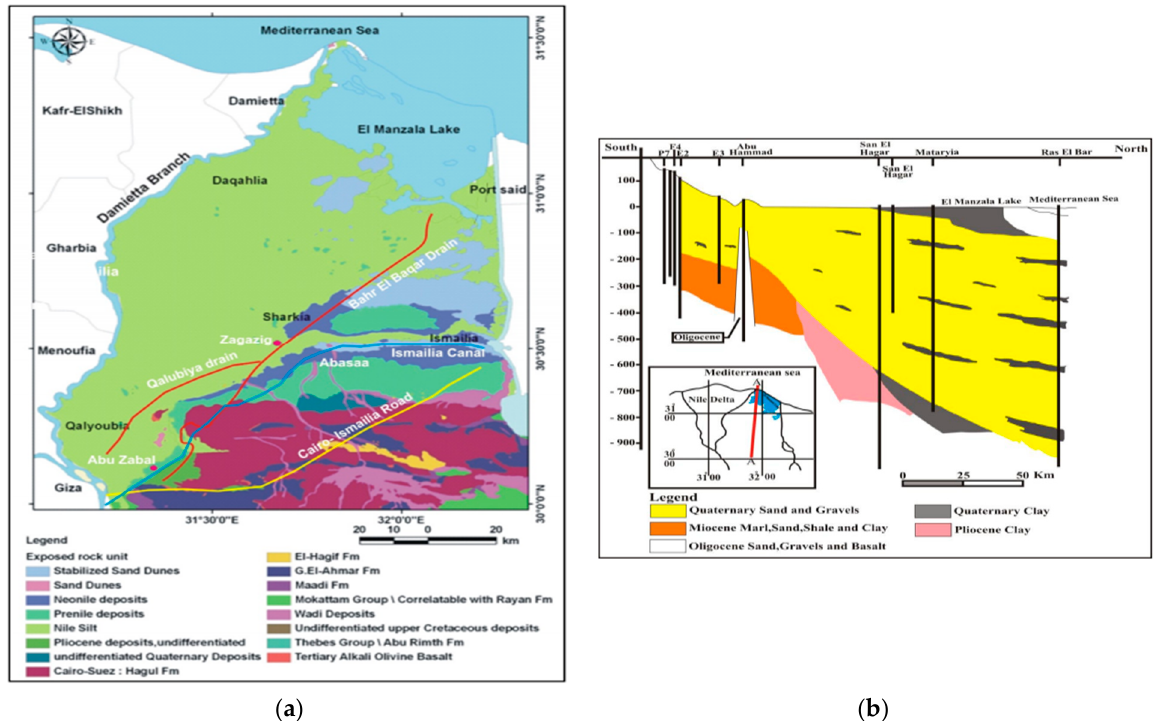
Figure 1. ( a ) Location map of the study area [24], ( b ) hydrogeological cross − sections of the Quaternary aquifer in the Nile Delta [13].